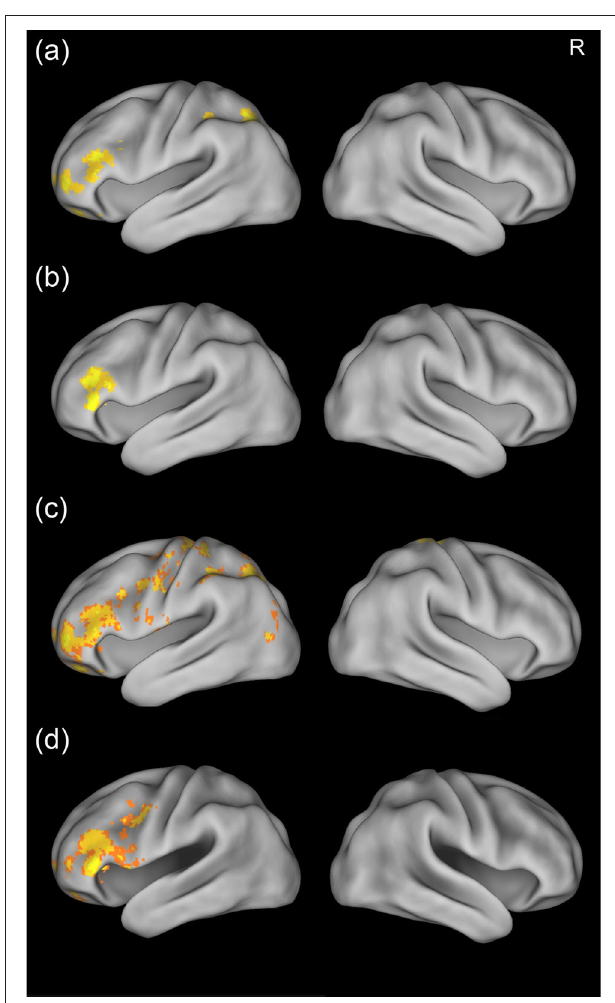
FIGURE 4 | Training effects for the artificial language words. The upper two panels show brain maps corrected using the Gaussian random field (GRF) theory, while the lower two panels show brain maps corrected using non-parametric permutation test, There was greater activation in the left inferior frontal gyrus and superior parietal cortex for the mid-training scan than for the pre-training scan (A,C) and greater activation in the left inferior frontal cortex for the post-training scan than for the pre-training scan (B,D) . R, right.